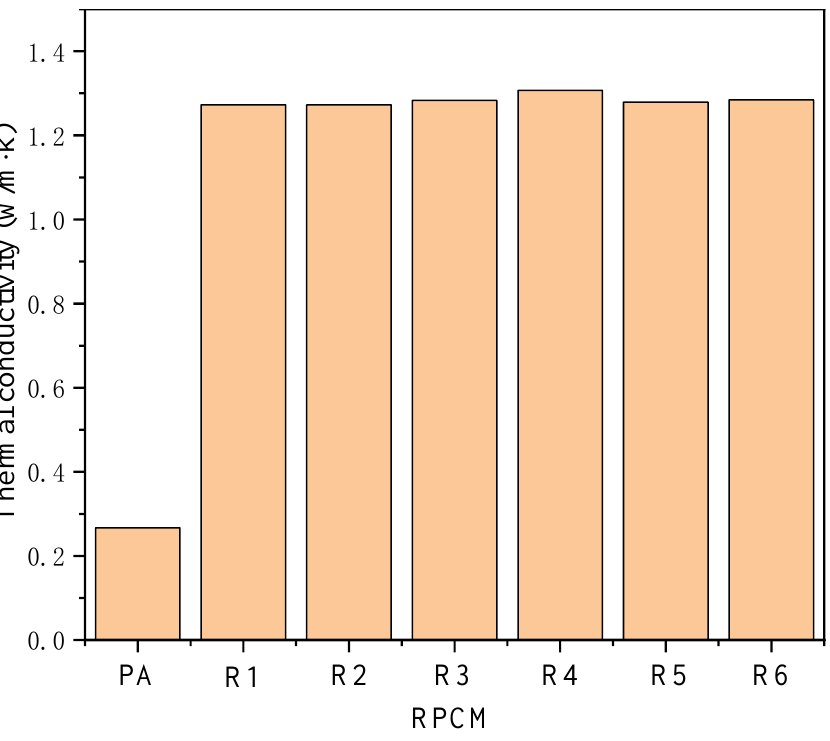
Figure 5. Thermal conductivity of RPCM. Figure 6 shows the DSC curve of flame-retardant PCM. It can be observed that the potential heat of flame-retardant PCM is lower than that of PA, and the melting point is lower. The latent heat of flame-retardant PCM R1-R6 is 170.3 J · g − 1 , 155 J · g − 1 , 130.1 J · g − 1 , 169.4 J · g − 1 , 147.3 J · g − 1 , and 121 J · g − 1 , respectively. The decrease in latent heat of